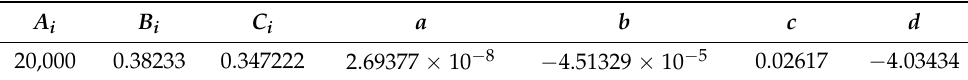
Table 4. The material property constants and the model coefficients of the water-cooled SCC speci-